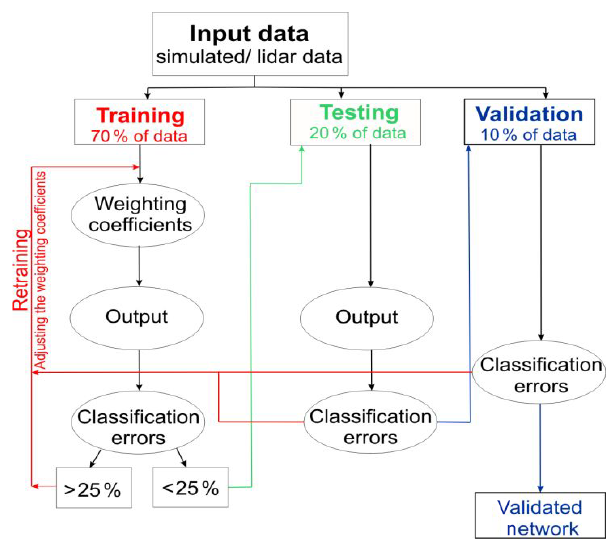
Figure 2. Artificial neural network logical scheme for the NATALI